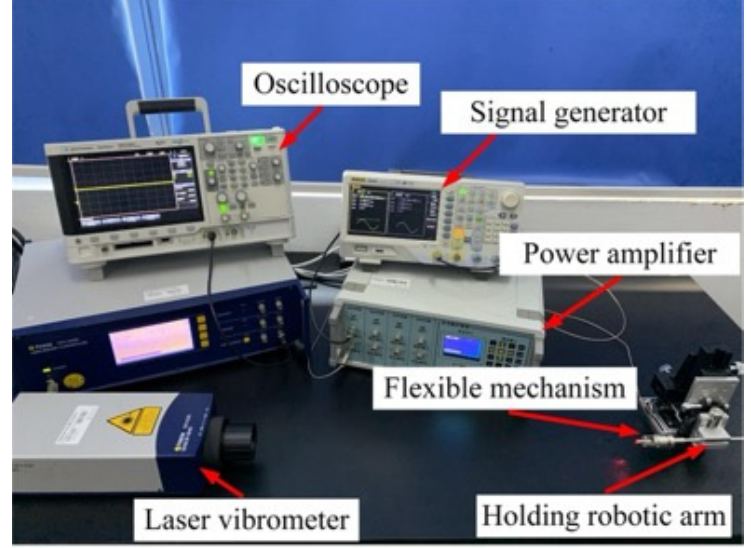
Figure 6. Vibration test platform for the output shaft of the microdissection device with flexure mechanism.